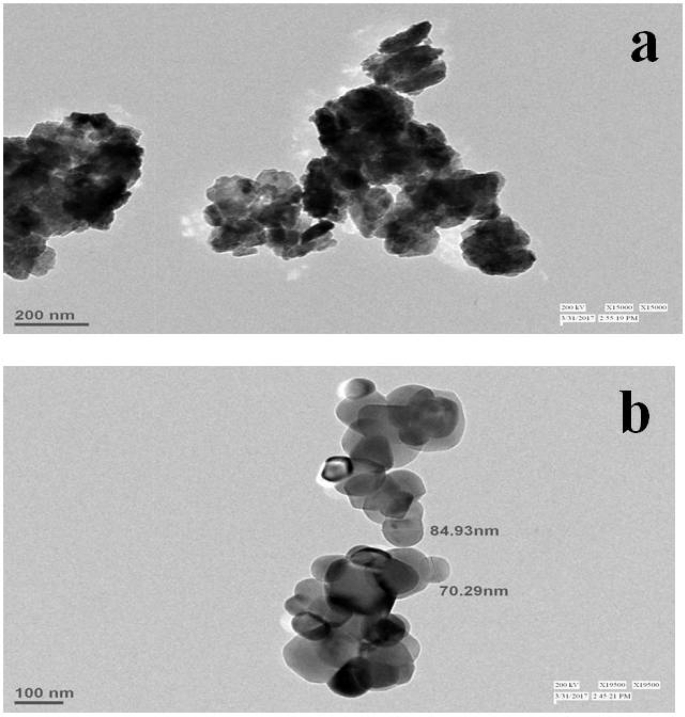
TEM images of synthesized (a) ZnO NPs and (b) TiO2 NPs.